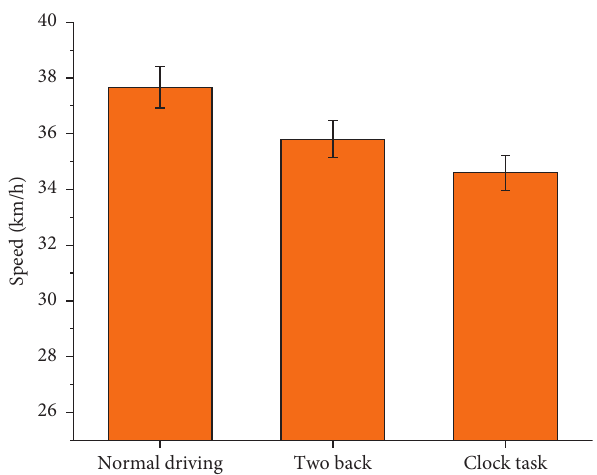
Figure 11: Main effect of the driving tasks on the speed.